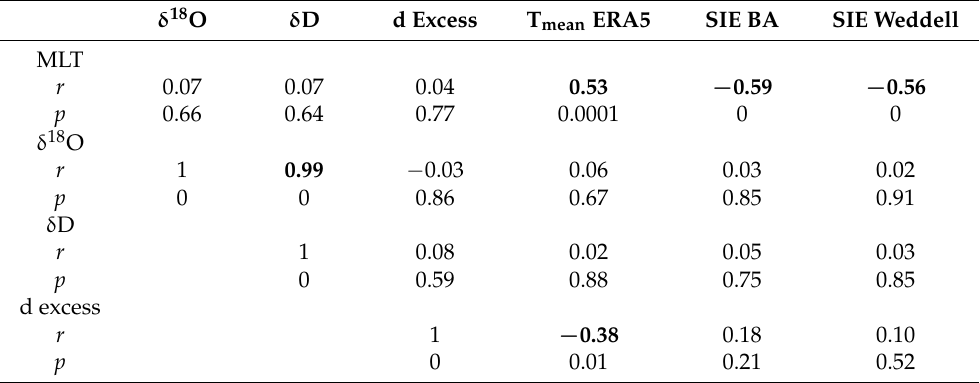
Table 5. Results of cross-correlation analysis for monthly records of δ 18 O, δ D, d excess and total melt layer thickness (MLT) of firn core OH-12 and monthly time series of ERA5 near-surface air tempera- ture at Plateau Laclavere, sea ice extent (SIE) in the Bellingshausen-Amundsen (BA) and Weddell Seas (Weddell). Prominent correlations with a low p -value ( p < 0.01, α = 0.05) are marked bold. δ 18 O δ D d Excess T mean ERA5 SIE BA SIE Weddell MLT r 0.07 0.07 0.04 0.53 − 0.59 − 0.56 p 0.66 0.64 0.77 0.0001 0 0 δ 18 O r 1 0.99 − 0.03 0.06 0.03 0.02 p 0 0 0.86 0.67 0.85 0.91 δ D r 1 0.08 0.02 0.05 0.03 p 0 0.59 0.88 0.75 0.85 d excess r 1 − 0.38 0.18 0.10 p 0 0.01 0.21